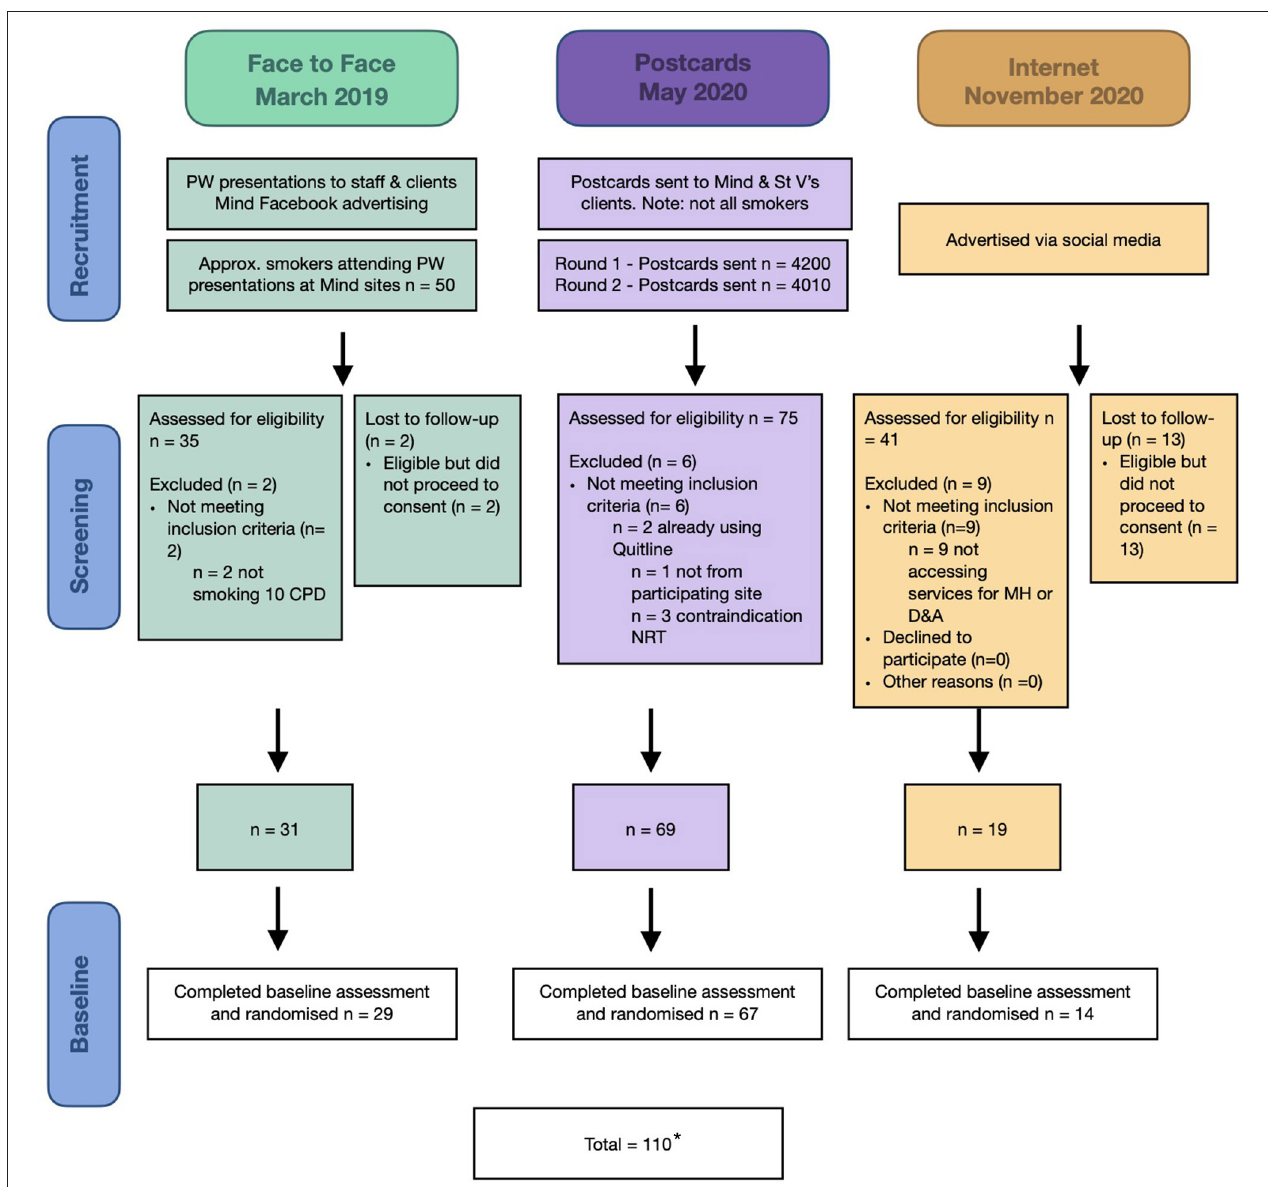
FIGURE 1 | CONSORT diagram. *One person withdrew from the study.